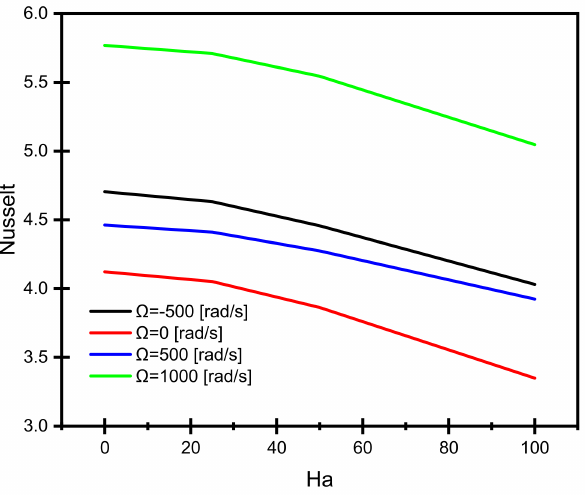
Figure 7. Effect of the Hartmann number on the average Nusselt number at different values and directions of the cylinder